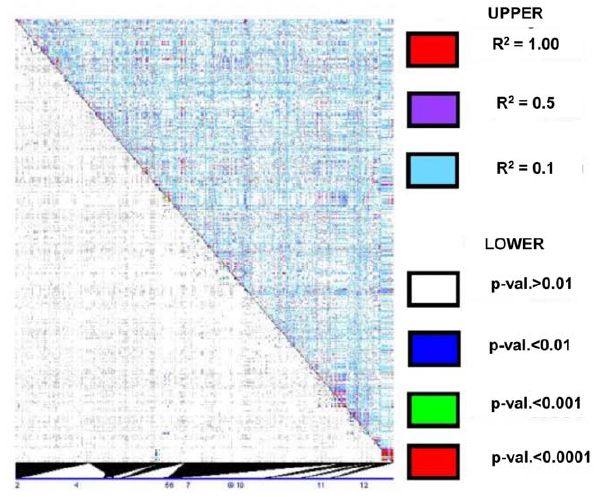
Figure 7. LD plot containing 10 members of the ZmLOX gene family. The LD plot of all SNPs from the Maize HapMap with 10 members of the ZmLOX gene family ( ZmLOX2, ZmLOX4, ZmLOX5, ZmLOX6, ZmLOX7, ZmLOX8, ZmLOX9, ZmLOX10, ZmLOX11, and ZmLOX12 ) ordered numerically from left to right shows little LD across all of the ZmLOX s except for ZmLOX12 , which is located in the lower right-hand corner.